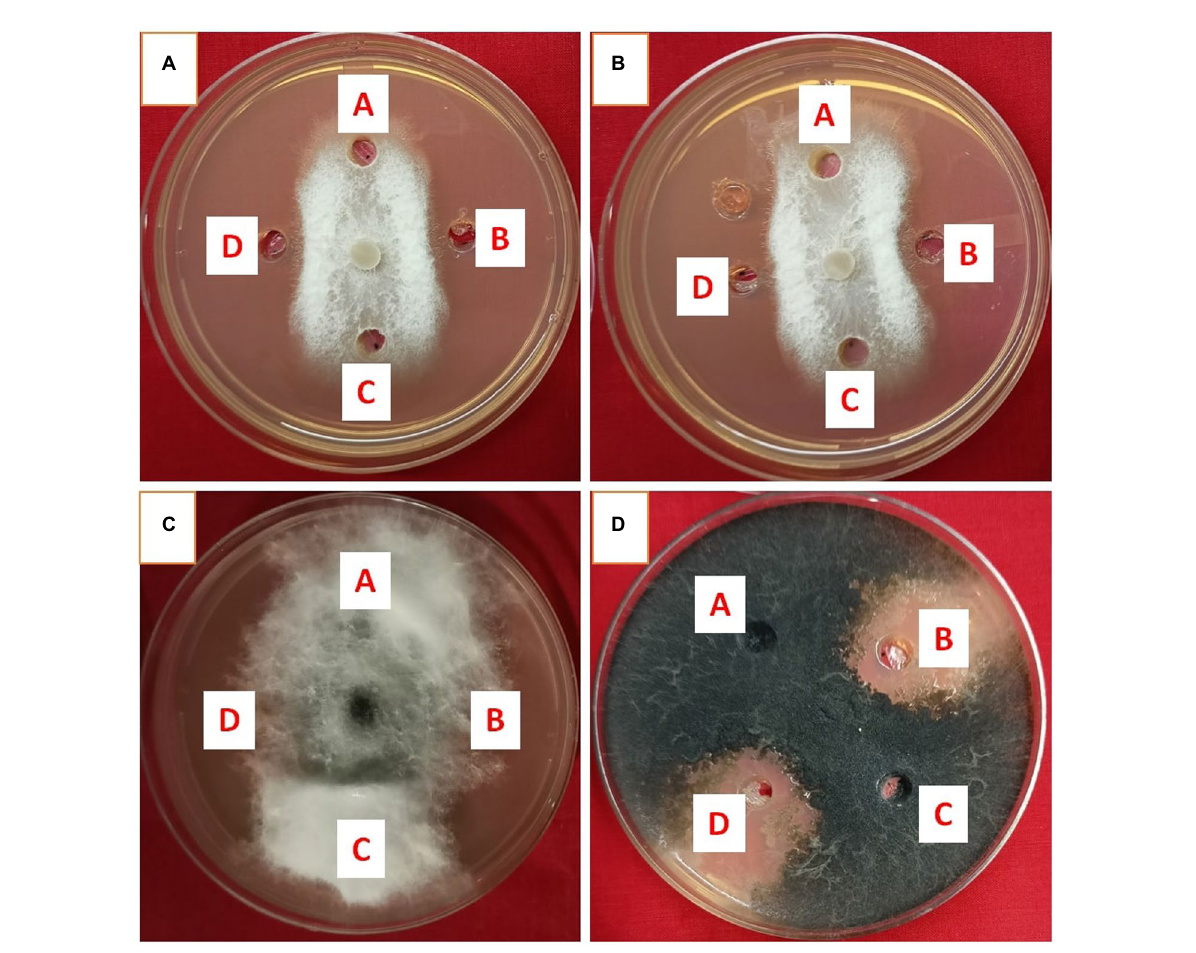
FIGURE 5 Antifungal activity of ethyl acetate extract of Streptomyces araujoniae TN19 in well diffusion assay against fungal pathogens Fusarium oxysporum (A) , Fusarium udum (B) , Macrophomina phaseolina (C) and Sclerotinia sclerotiorum (D) . Well A = Control, C = solvent control, B and D = ethyl acetate extract (20 μ